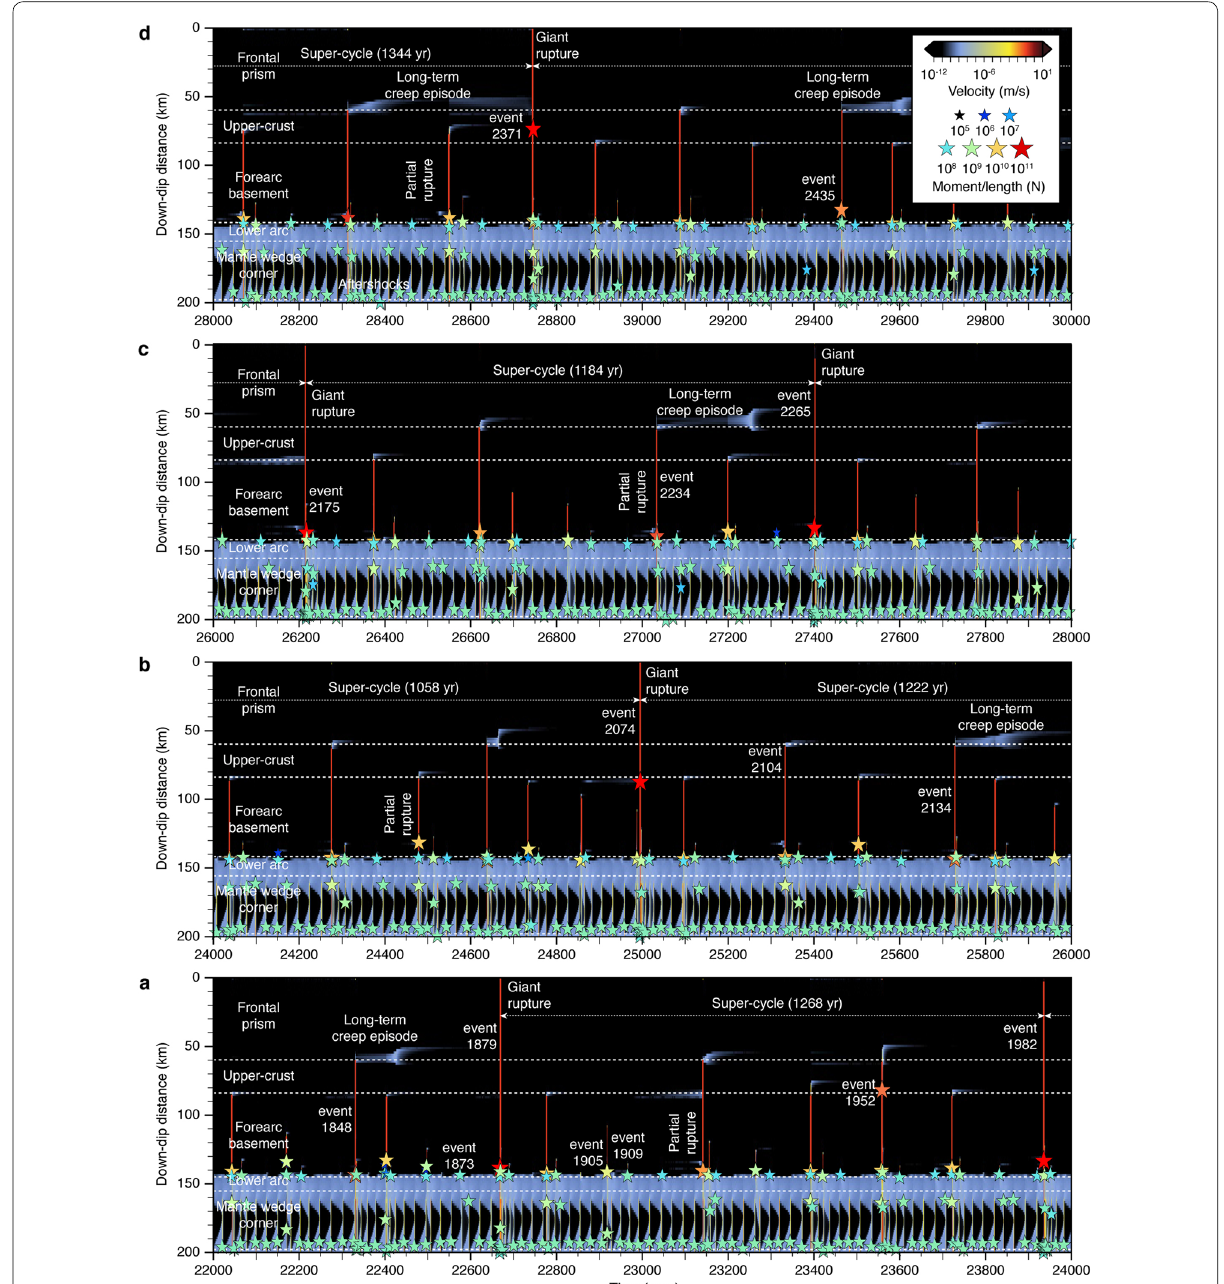
Fig. 3 Numerical simulations of 8000 years of seismic super-cycles at the Japan trench (Miyagi section) that was preceded by a 22,000-year period. a Seismic cycle from 22,000 to 24,000 years. b Period from 24,000 to 26,000 years. c Period 26,000 to 28,000 years. d Period 28,000 to 30,000 years. Super-cycles (thin dashed lines) are defined as the period separating two full ruptures of the forearc. Long-term creep in the velocity-weakening domain may take place near fault bends or near the rupture tip of previous partial ruptures. The domain boundaries are shown by the white dashed lines. The stars indicate the hypocenter and magnitude (moment per unit length) of the simulated ruptures. The event number indicates simulated seismic events during which the peak velocity has exceeded an initial threshold of 1 cm/s and then maintained a peak velocity above 0.1